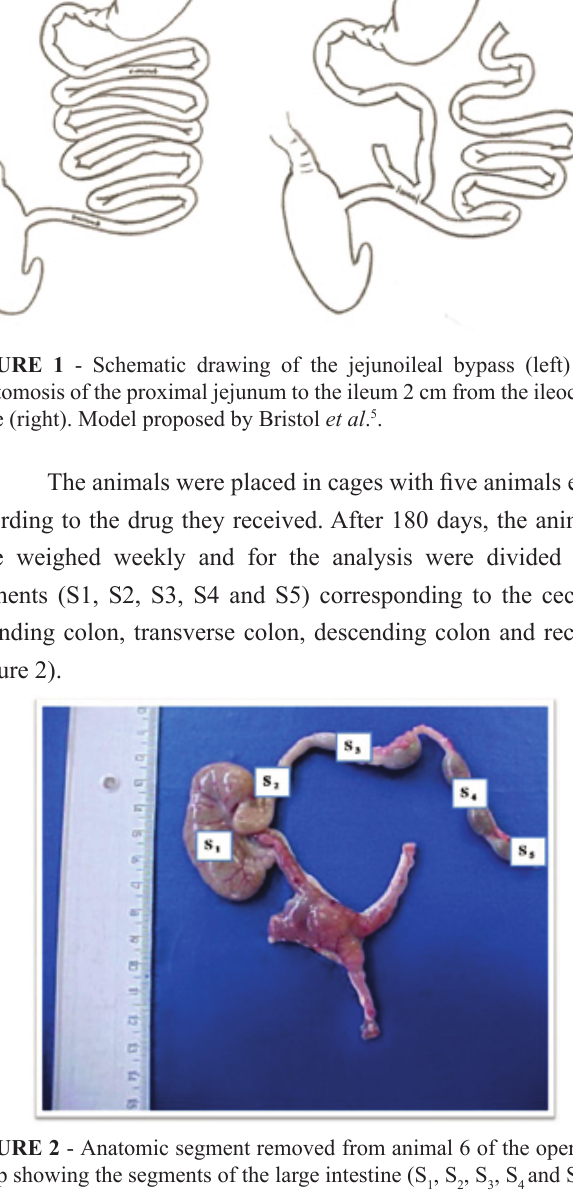
, S , S , S and S 1 2 3 4 5